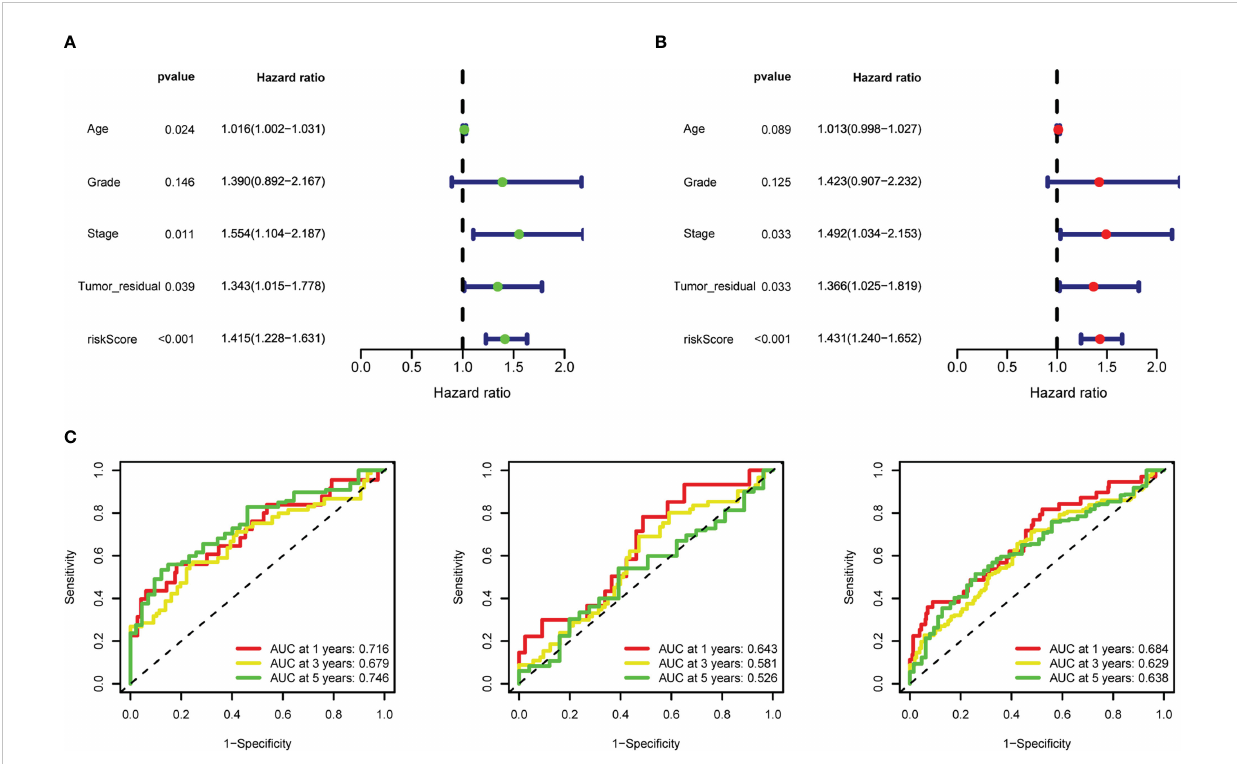
FIGURE 7 Riskscore as an independent prognostic factor. (A) Univariate Cox regression analysis of riskscore, age, stage, grade, tumor residual size. (B) Multivariate Cox regression analysis of riskscore, age, stage, grade, tumor residual size. (C) 1-, 3-, and 5-year time-dependent receiver operating characteristic (ROC) curves of the training, testing, and whole datasets,